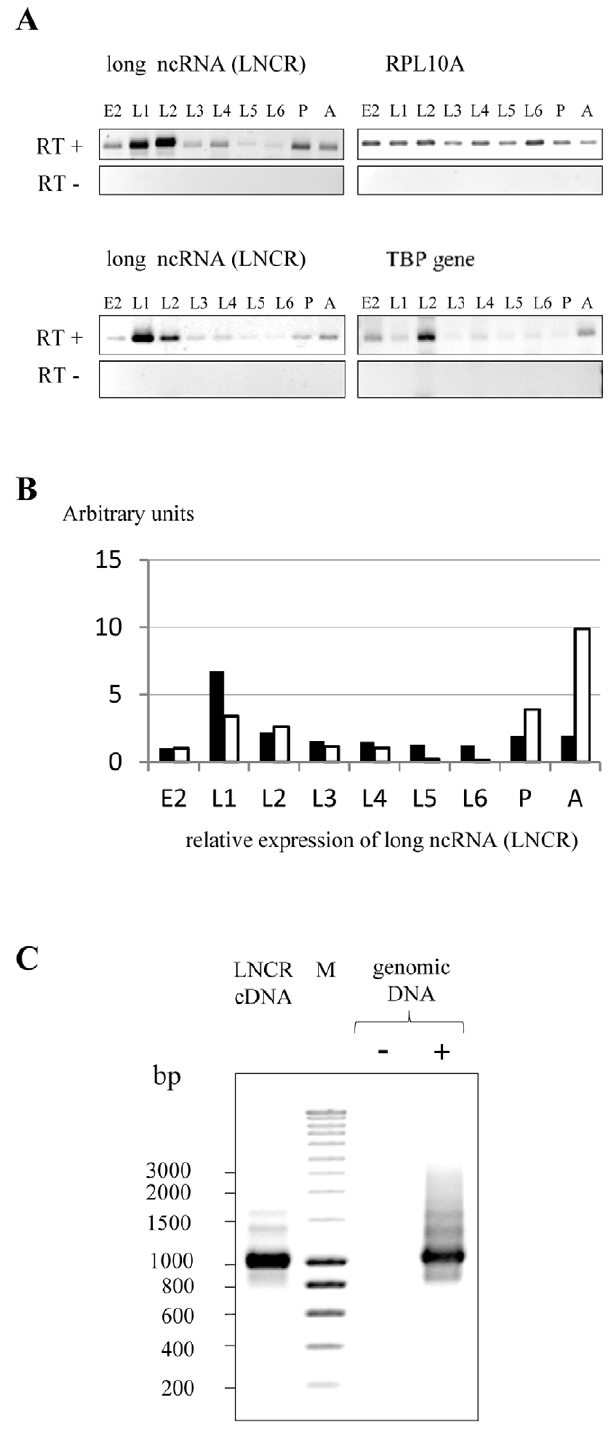
Figure 3. Expression analysis of S. frugiperda long ncRNA (LNCR) during different developmental stages. A) Expression analysis of S. frugiperda long ncRNA (LNCR) during different develop- mental stages (E2- 2.5 days old fertilised eggs, L1–L6 larval stages, P- 12- day old pupae and A- adults) by semi quantitative RT PCR. PCR was done on total RNA treated with reverse transcriptase (RT + ) or without it (RT 2 ). Expressions of ribosomal gene RPL10A and TBP (TATA binding protein) were used as endogenous control genes. PCR was done with primers amplifying the LNCR region from 27–1271 (upper panel) and LNCR region from 858–1271 nt (lower panel). B) Graph presenting